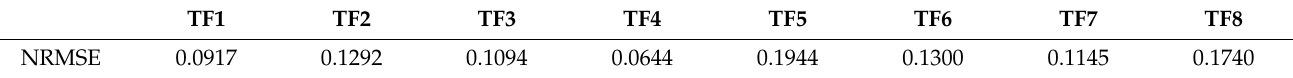
Figure 10. Visualisation of the prediction models using multiple datasets by applying machine learning on all datasets. The number in the title refers to the number of the tissue flask used as the test set. ( a ) visualizes the prediction model developed using RBF LS-SVM with TF1 (from the dataset) as the test set. ( b ) visualizes the prediction model developed using RBF LS-SVM with TF6 (from the dataset) as the test set. Table 12. NRMSE comparing the accumulated lactate output values of the forecast model using multiple datasets by applying machine learning using the goodnessOfFit function in MATLAB. The NRMSE closer to zero represents the better fit. The number of the tissue flasks referrers to the tissue flask used as the test data set.